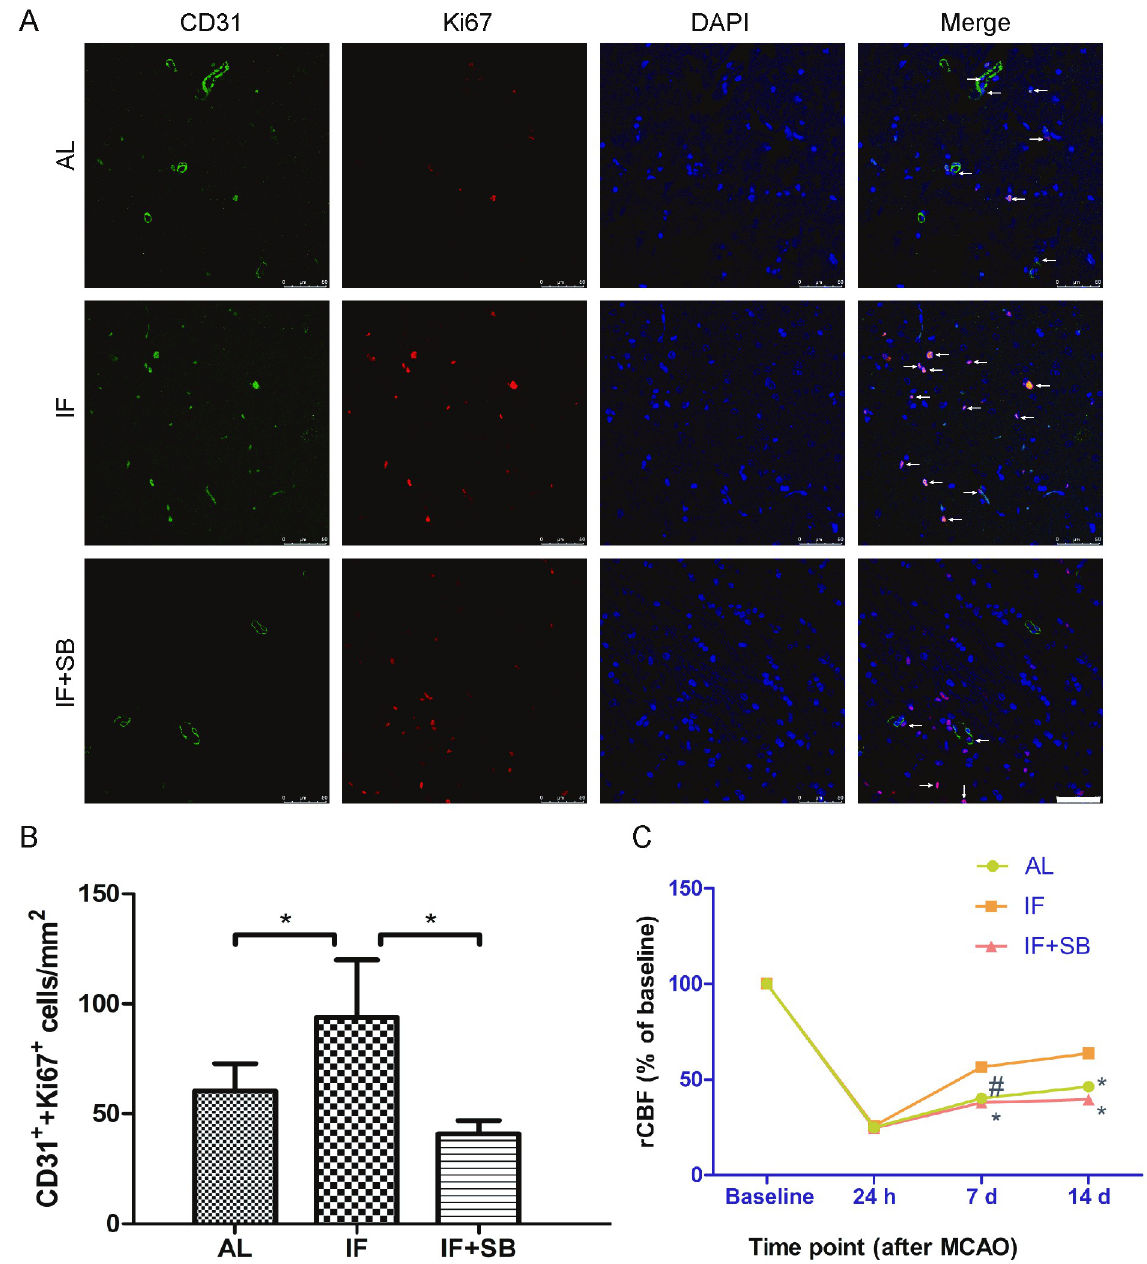
Fig 4. Long-term IF conditioning stimulates proliferation of ECs and improves rCBF after CI through the GDF11/ALK5 pathways. ( A ) Proliferation of ECs 7 d after MCAO in each group as indicated by immunofluorescence. Arrows show the colocalization of CD31 (green stain) and Ki67 (red stain) in each group. Scale bar, 50 μ m. ( B ) Bar graph showing the CD31 + /Ki67 + cells/mm 2 in each group. * p < 0.01 in comparison with the IF group (n = 8/group). ( C ) rCBF (relative to baseline) as indicated by laser Doppler flowmetry in each group. # p < 0.05, * p < 0.01 compared with the IF group at the same time point (n = 8/group).